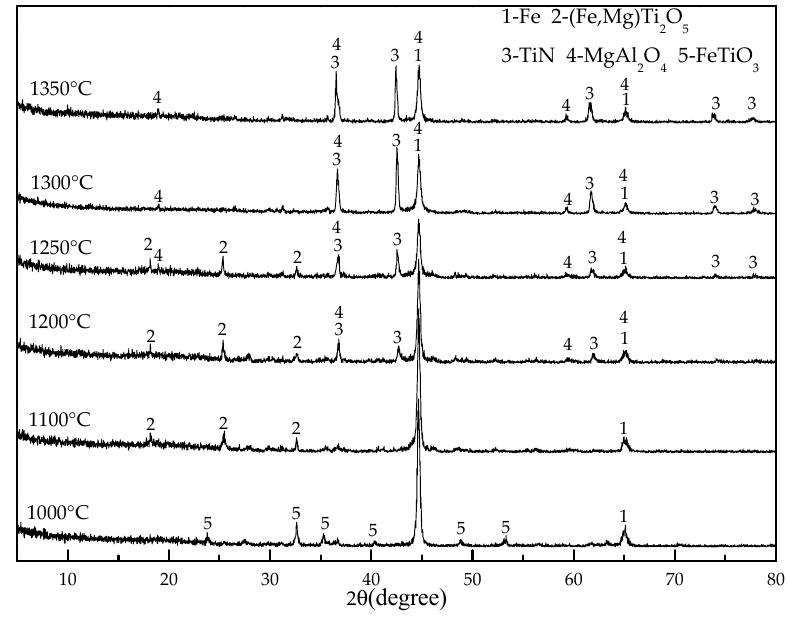
Figure 2. XRD patterns of pellets with 26 wt % coal reduced over a range of temperatures for 90 min.